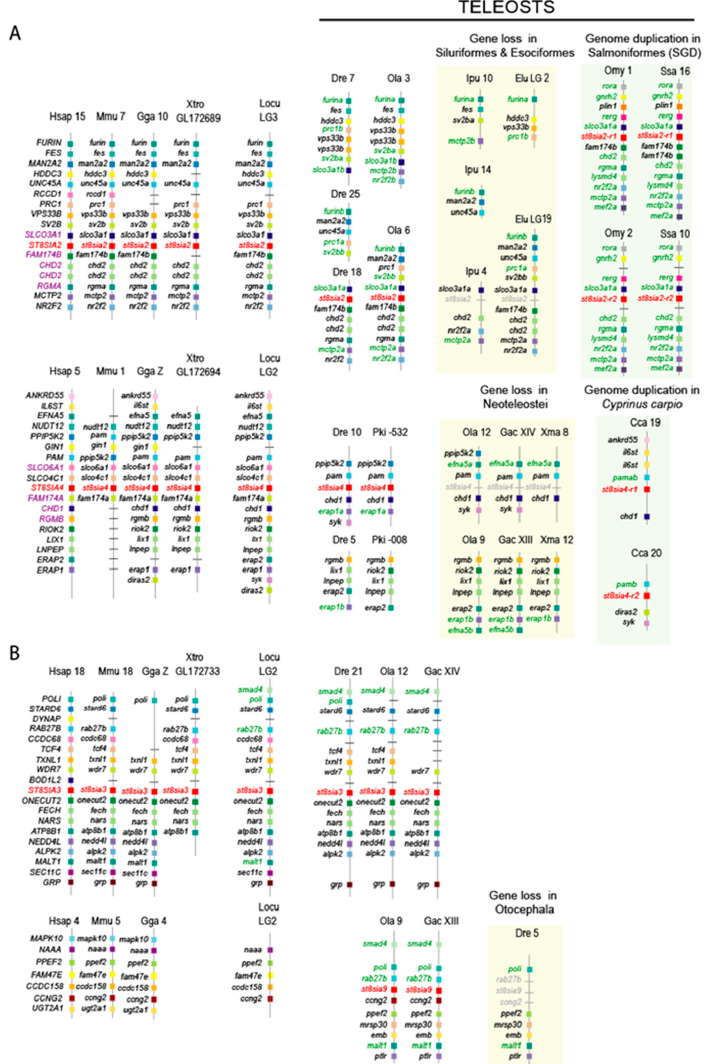
Figure 3. Syntenic relationships of the oligo- and poly- α 2,8-sialyltransferases gene loci in vertebrates. Chromosomal locations of the st8sia genes and neighboring gene loci were determined in the human ( Homo sapiens , Hsa), the mouse ( Mus musculus (Mmu), the chicken ( Gallus gallus , Gga), the spotted gar ( L. oculatus , Locu), the western clawed frog ( Xenopus tropicalis , Xtro), the zebrafish ( D. rerio , Dre), the Japanese medaka ( O. latipes , Ola), the channel catfish ( I. punctatus , Ipu), the northern pike ( E . lucius , Elu), the rainbow trout ( O. mykiss , Omy), the Atlantic salmon ( Salmo salar , Ssa), the African weakly electric fish ( Paramormyrops kingsleyae , Pki), the three-spined stickleback ( G. aculeatus , Gac), the southern platyfish ( X. maculatus , Xma), and the European carp ( C. carpio , Cca). Information from the National Center for Biotechnology Information (NCBI) and ENSEMBL release 97 was used to identify putative orthologues, which were visualized using the Genomicus 97.01 [53]. Paralogous genes in the fish genomes are indicated in green and in purple in the human genome. The st8sia genes are indicated in red or in grey when lost. ( A ) Syntenic relationships of the st8sia2 and st8sia4 gene loci in vertebrates. ( B ) Syntenic relationships of the st8sia3 and st8sia9 gene loci in vertebrates. The synteny around the st8sia3 gene locus including wdr7 , onecut2 , and fech genes is highly conserved in vertebrate lineages from fish to mammals (Figure 3B). Synteny around st8sia9 locus is less conserved and is limited to a smaller syntenic block with ccng2 and ppef2 genes, which is reminiscent of ancient WGD followed by intrachromosomal rearrangement in the ancestral fish